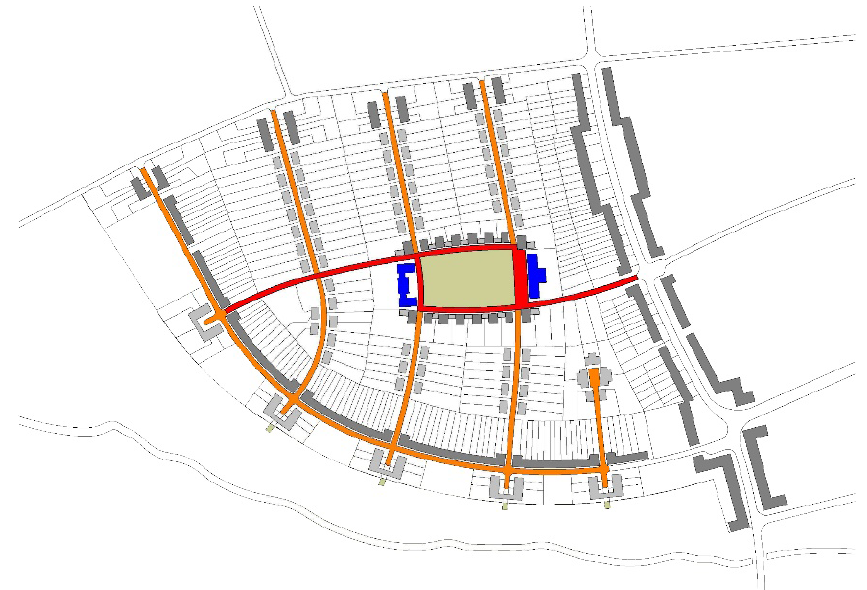
Figure 22. Formal structure, Siedlung Leobschütz. Drawings by Manlio